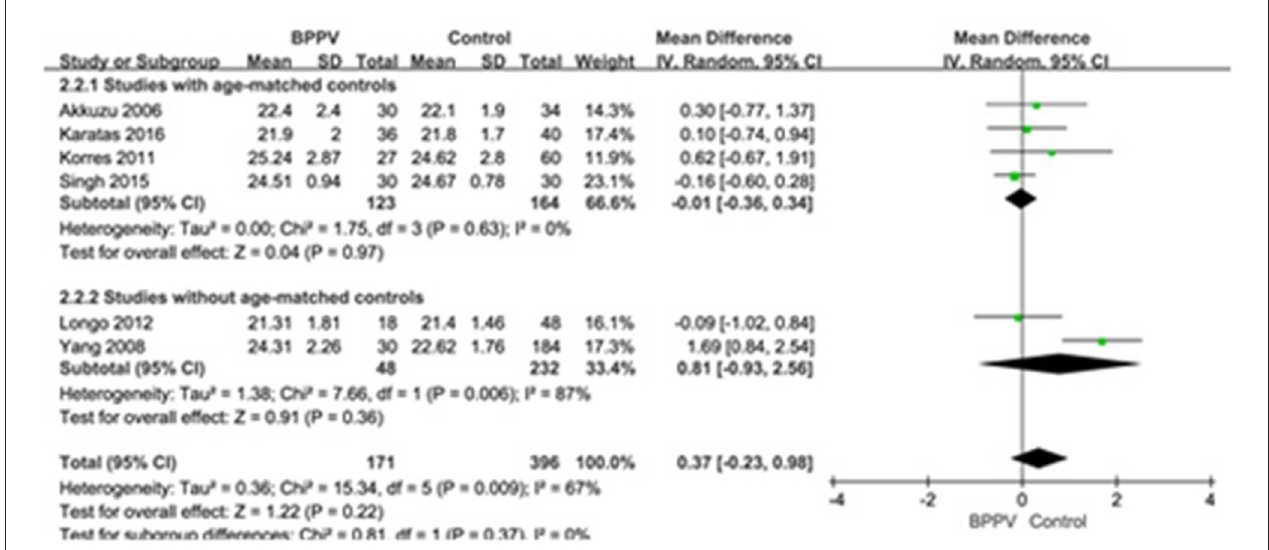
FIGURE 3 | Forest plots of subgroup meta-analysis of n23 latency of cVEMP based on whether or not the age matches between BPPV and healthy groups. BPPV, benign paroxysmal positional vertigo; cVEMP, cervical vestibular evoked myogenic potential.